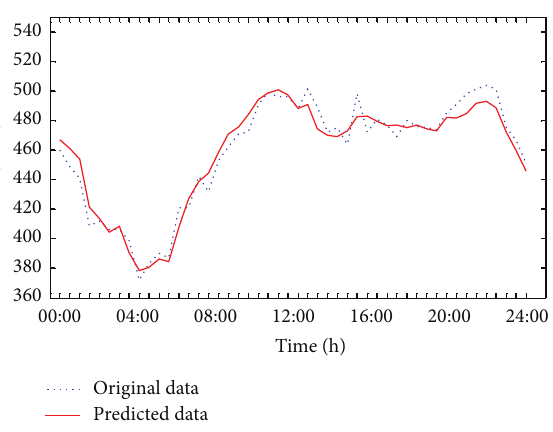
Figure 3: The relative error curve.